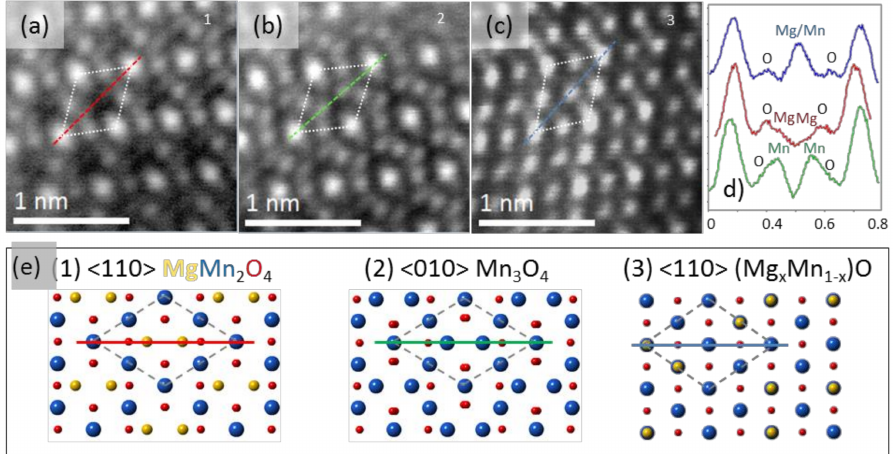
Figure 6. STEM-HAADF cutouts from micrographs taken from a sample cycled for 5 cycles in water based Mg(NO 3 ) 2 electrolyte showing different atomic arrangements within cycled manganese spinel and corresponding atomic models of ( a , e1 ) cubic MgMn 2 O 4 , ( b , e2 ) tetragonal Mn 3 O 4 , and ( c , e3 ) cubic Mg x Mn 1-x O rock salt structures. In ( d ), three intensity line profiles taken along the lines with corresponding colors marked in ( a – e ) are